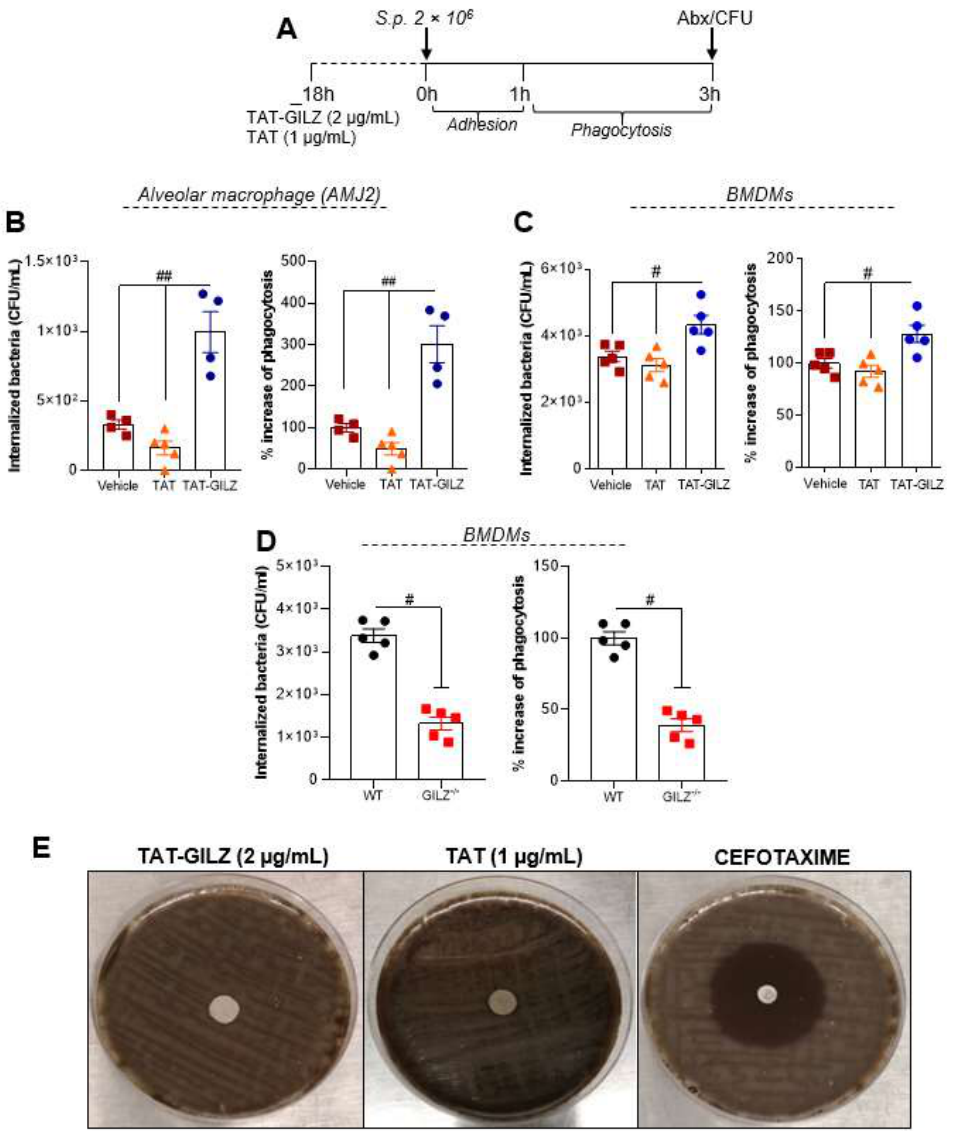
Figure 6. TAT-GILZ enhanced macrophages phagocytosis of Streptococcus pneumoniae. Phagocytosis of bacteria–Experimental design in ( A )–were evaluated in alveolar macrophages (AMJ2-C11) ( B ) or BMDMs obtained from WT mice ( C ). Macrophages (2 × 10 5 ) were pre-treated with TAT (1 µ g/mL) or TAT-GILZ (2 µ g/mL) for 18 h and then incubated with S. pneumoniae (MOI 1:10) for 3 h to allow adhesion and phagocytosis. Noninternalized bacteria were excluded by the incubation of the cells with penicillin/streptomycin (Abx), followed by the lysis of macrophages to identify the number of viable phagocytosed bacteria. In other experimental group BMDMs from naïve WT and GILZ − / − (2 × 10 5 ) were also subjected to phagocytosis as describe bellow ( D ). Results are expressed as CFU of internalized bacteria or % of phagocytosis (CFU counts on blood agar plates, N = 4–5) and are presented as mean ± SEM; # p < 0.05, ## p < 0.01 when comparing TAT-GILZ-treated cells to vehicle or TAT, by 1-way ANOVA (B–C). Comparison between BMDMs from WT and GILZ − / − were